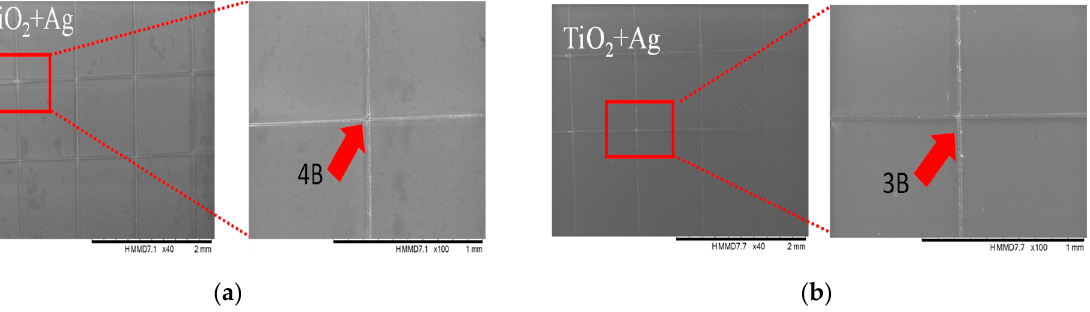
Figure 3. Illustrative SEM images of thin films after adhesion tests (red-colored arrow indicates the delamination/detached area) for SiO 2 + Ag ( a ) and TiO 2 + Ag ( b ).